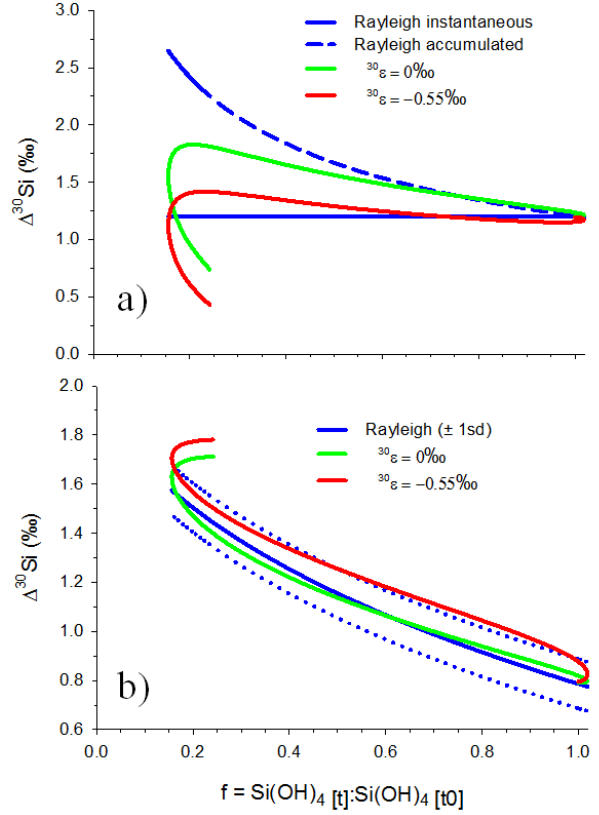
Fig. 7. (a) Simulated 1 30 Si ( = δ 30 Si Si ( OH ) – mixed layer 4 δ 30 Si bSiO ) vs. relative Si-utilisation in the mixed layer 2 ( = [Si(OH) 4 ] (t) :[Si(OH) 4 ] (t 0 ) ) without (green line) and with (red line) an isotopic fractionation during bSiO 2 dissolution. The isotopic difference between the Rayleigh δ 30 Si Si ( OH ) and either 4 Rayleigh instantaneous δ 30 Si bSiO (full blue line) or Rayleigh 2 accumulated δ 30 Si bSiO (dashed blue line) are also shown. (b) 2 Simulated relationship between accumulated exported δ 30 Si bSiO 2 and relative Si-utilization in the mixed layer without (green line) and with (red line) an isotopic fractionation during bSiO 2 dissolu- tion. The relationship with the Rayleigh accumulated δ 30 Si bSiO 2 (full blue line; 1 standard deviation = dashed blue lines) is also shown to